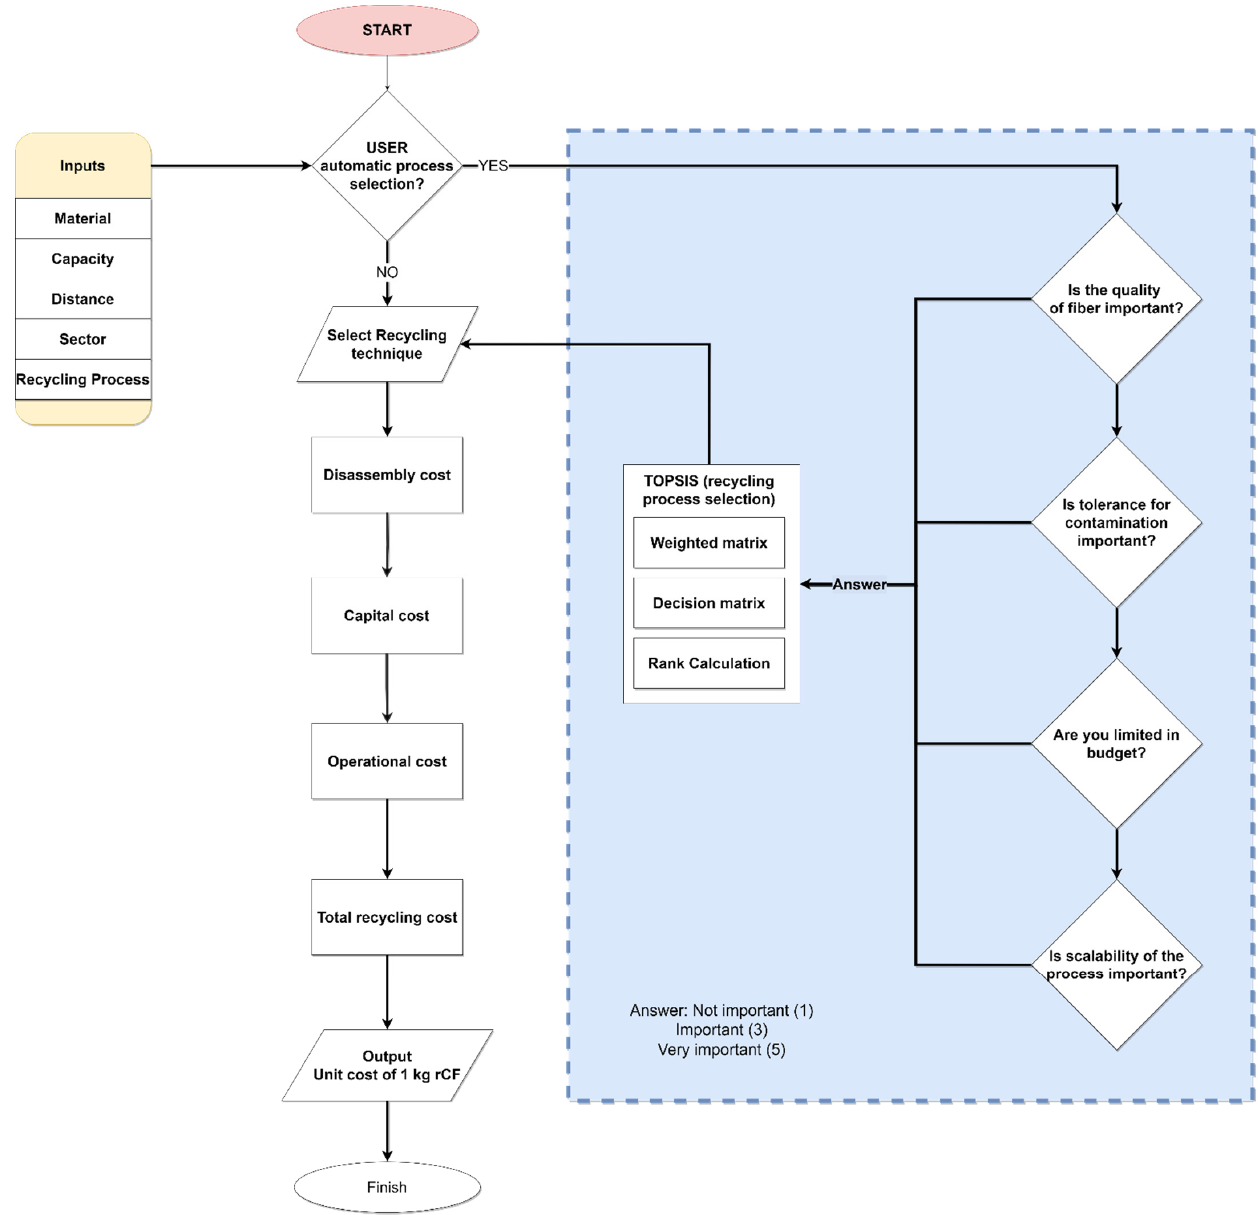
Figure 3. System scenario for the total recycling cost estimation process.